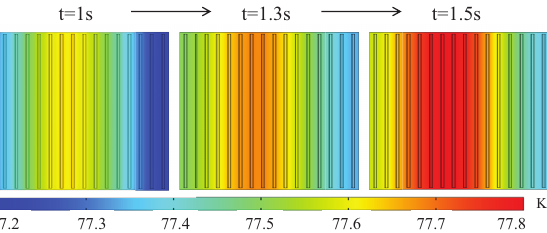
Figure 5. The time evolutions of internal temperature distribution of a 16-turn coil.